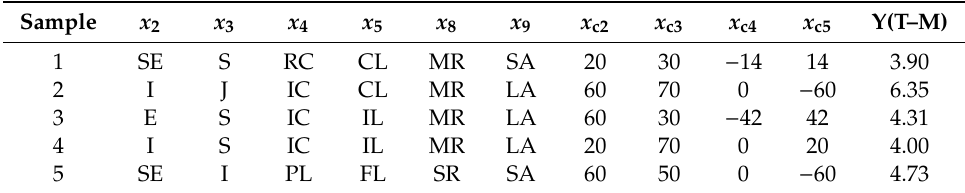
Table 6. Input and output values of the seat test samples.